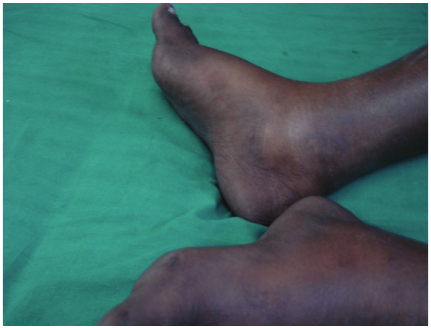
Figure 4: Hyperpigmentation in